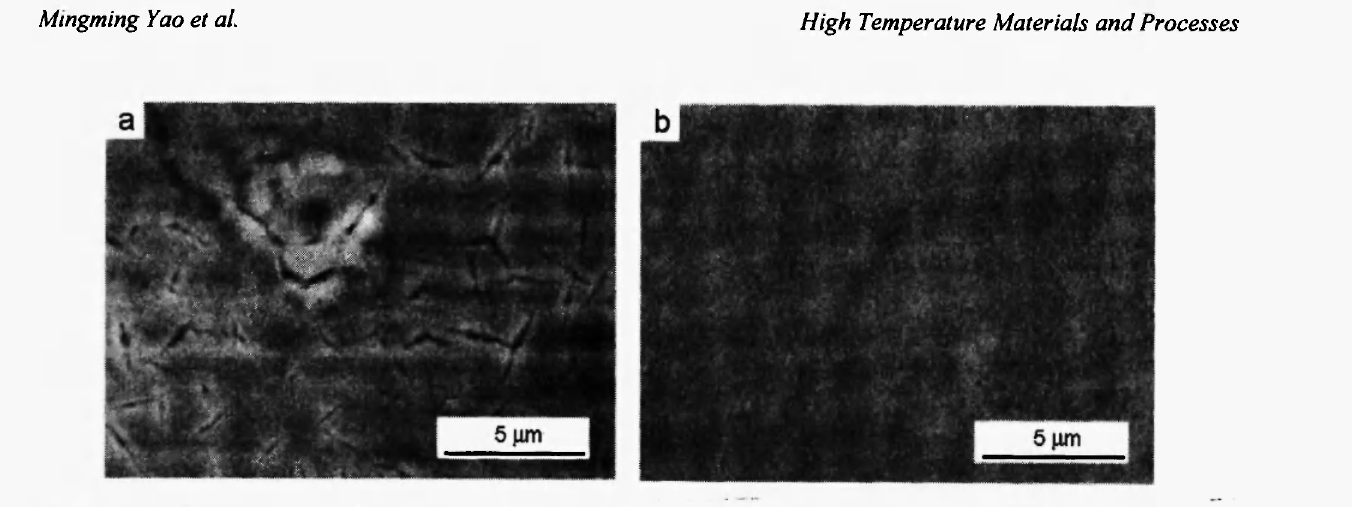
Fig. 1: SEM images of micro-laminated coating on two-layer coating, and b) six-layer coating.